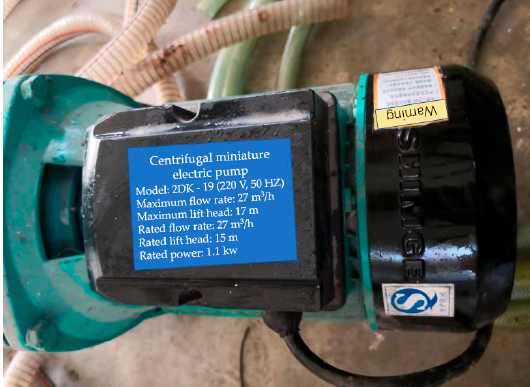
Figure 6. Liquid circulation system.